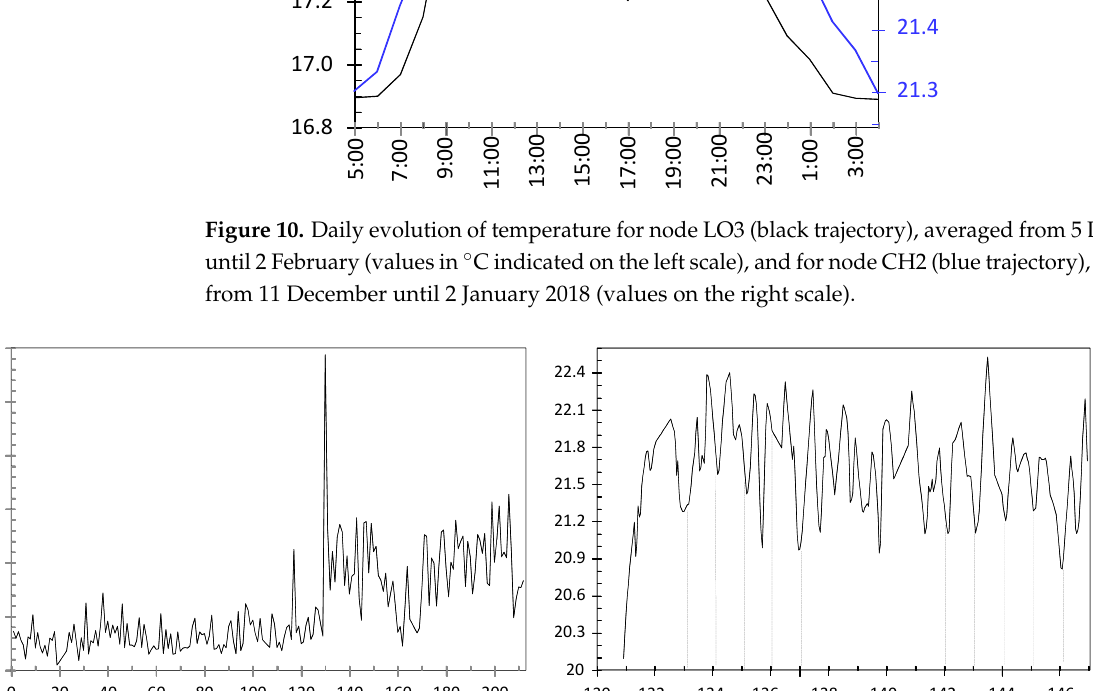
Figure 10. Daily evolution of temperature for node LO3 (black trajectory), averaged from 5 Decem- ber until 2 February (values in ° C indicated on the left scale), and for node CH2 (blue trajectory),